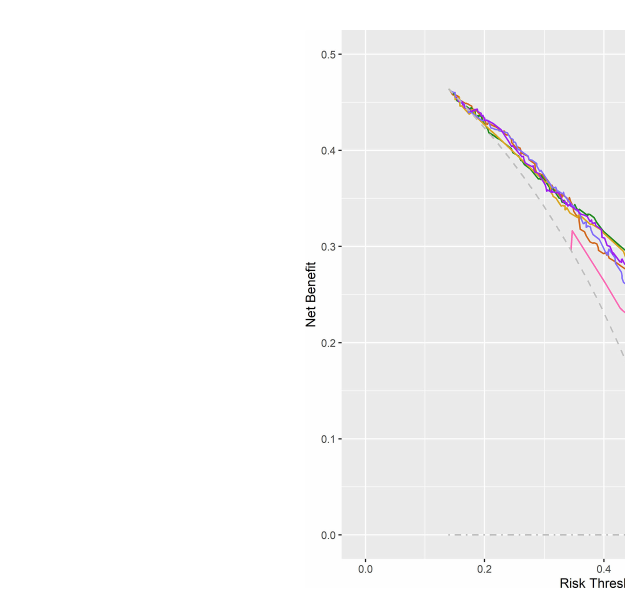
FIGURE 5 Decision curve analysis of the machine learning models in the internal testing cohort.